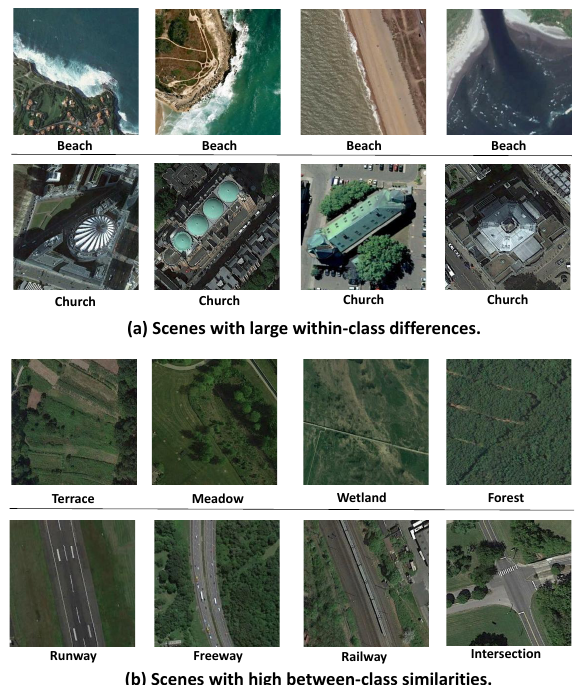
Figure 2. Examples of different classes in remote-sensing scene images. The early research methods are mainly based on low-level features, which represent the features of remote-sensing scene images by selecting different feature description